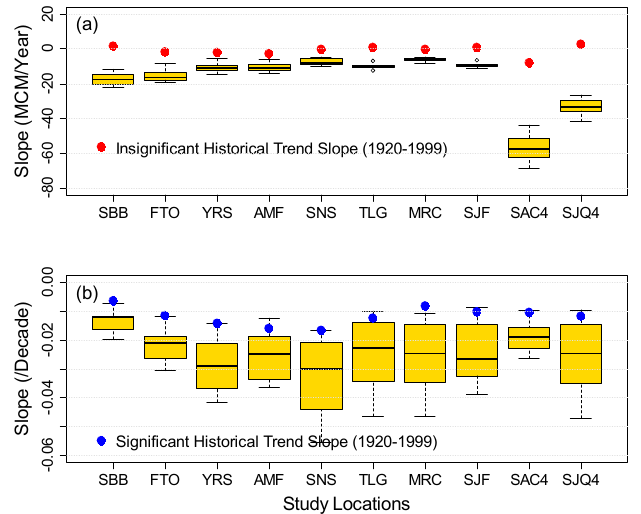
Figure 8. Box-and-whisker plots of significant trend slope in projected ( a ) April–July runoff and ( b ) April–July runoff over annual runoff ratio for all RCP 4.5 and RCP 8.5 projections from 2020–2099 with corresponding trend slope information in the historical period (1920–2099; in red and blue dots). Open circles indicate extreme